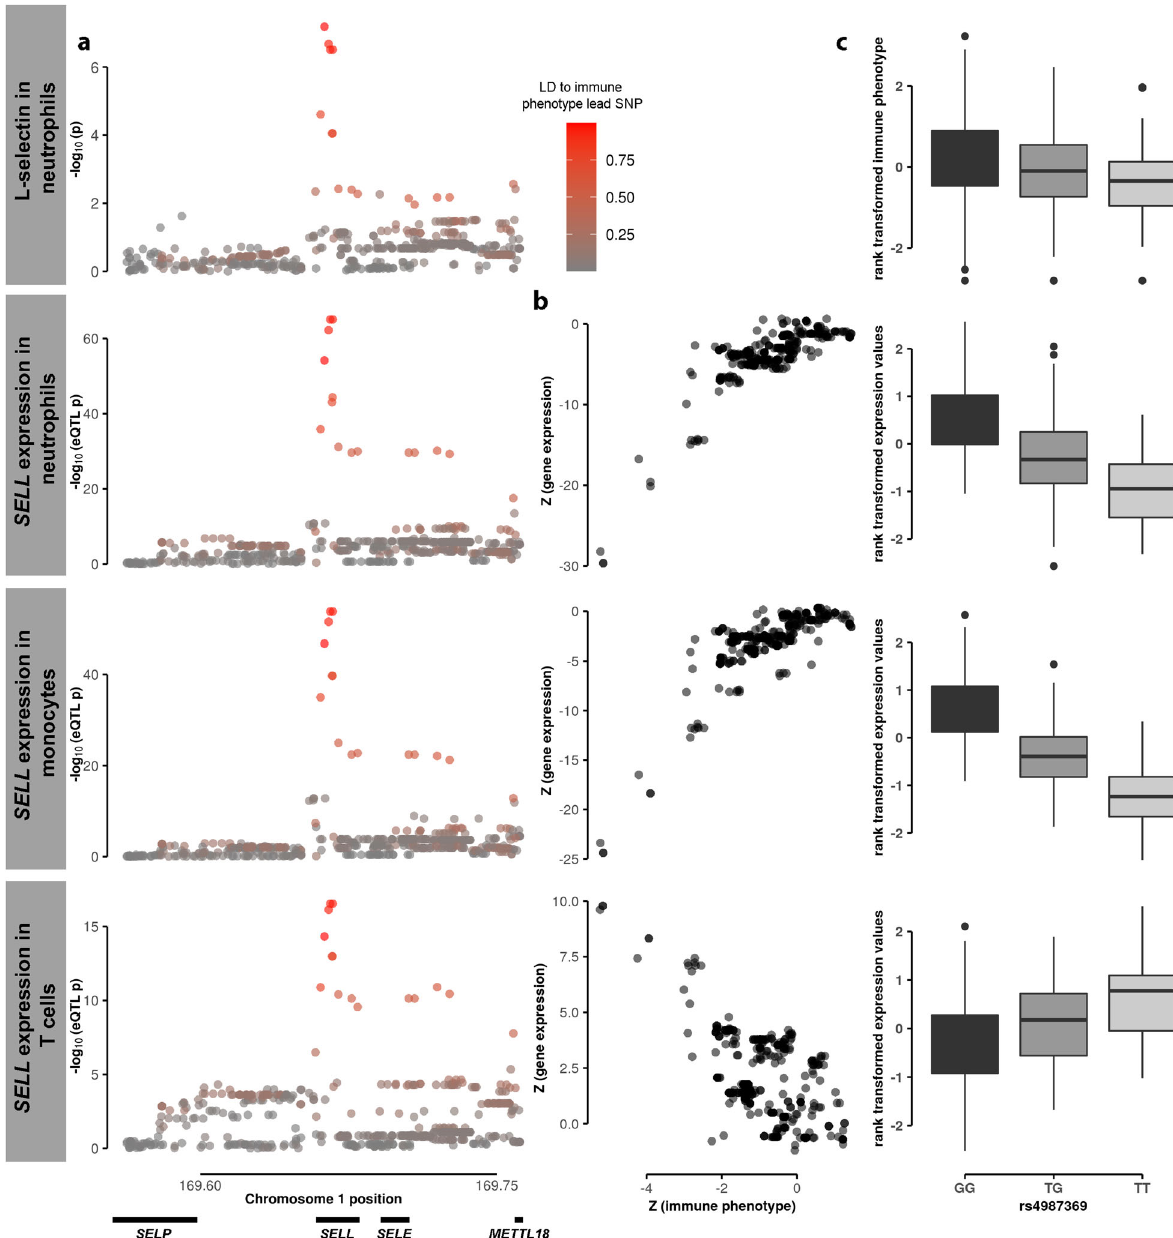
Fig. 1 Shared genetic association on chromosome 1 for L-selectin (CD62L) in neutrophils and SELL expression in neutrophils, monocytes and T cells. The association signal of the mean fl uorescence intensity (MFI) of L-selectin (CD62L) in neutrophils at a genetic locus on chromosome 1 is consistent with the association signal to SELL expression in neutrophils, monocytes and T cells at the same genetic locus ( a , shaded by linkage disequilibrium (LD, r 2 ) to the immune phenotype lead single nucleotide polymorphism (SNP)). The association Z statistics of the mean fl uorescence intensity (MFI) of L-selectin in neutrophils and SELL expression in the three different cell types are strongly correlated ( b ). c The MFI of L-selectin and SELL expression in the three different cell types (both rank transformed) per genotype of the lead variant